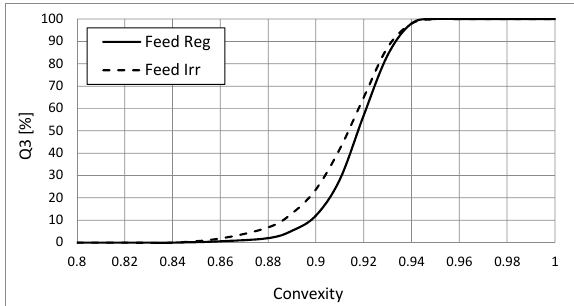
Figure 11. Distribution of selected shape coefficients for regular and irregular particles in feed material. Analysis of these graphs clearly shows that the coe ffi cient, which apparently indicates di ff erences in chalcedonite particle size, is circularity ( C ). Average values of the calculated shape coefficients for feed with regular particles are respectively: AR mean = 0.708, C x_mean = 0.918, C mean = 0.847, while for